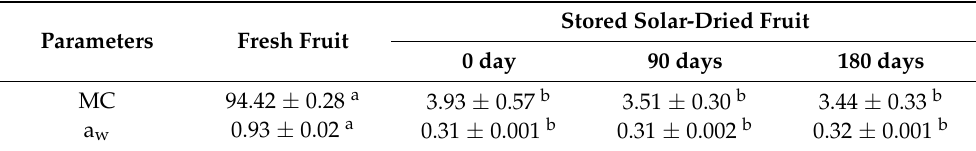
Table 1. Moisture content (%) and water activity (a w ) of fresh and solar-dried tomato slices.